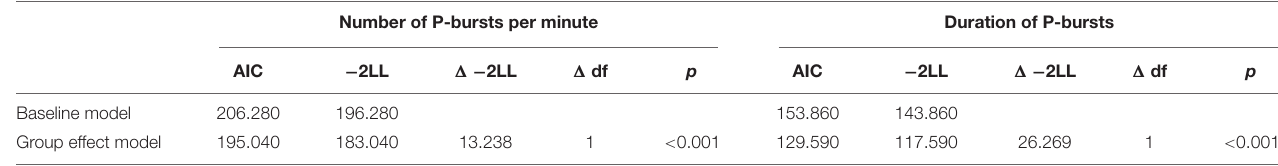
TABLE 5 | Comparison of the baseline and the group effect models for number of P-bursts per minute and duration of P-bursts.